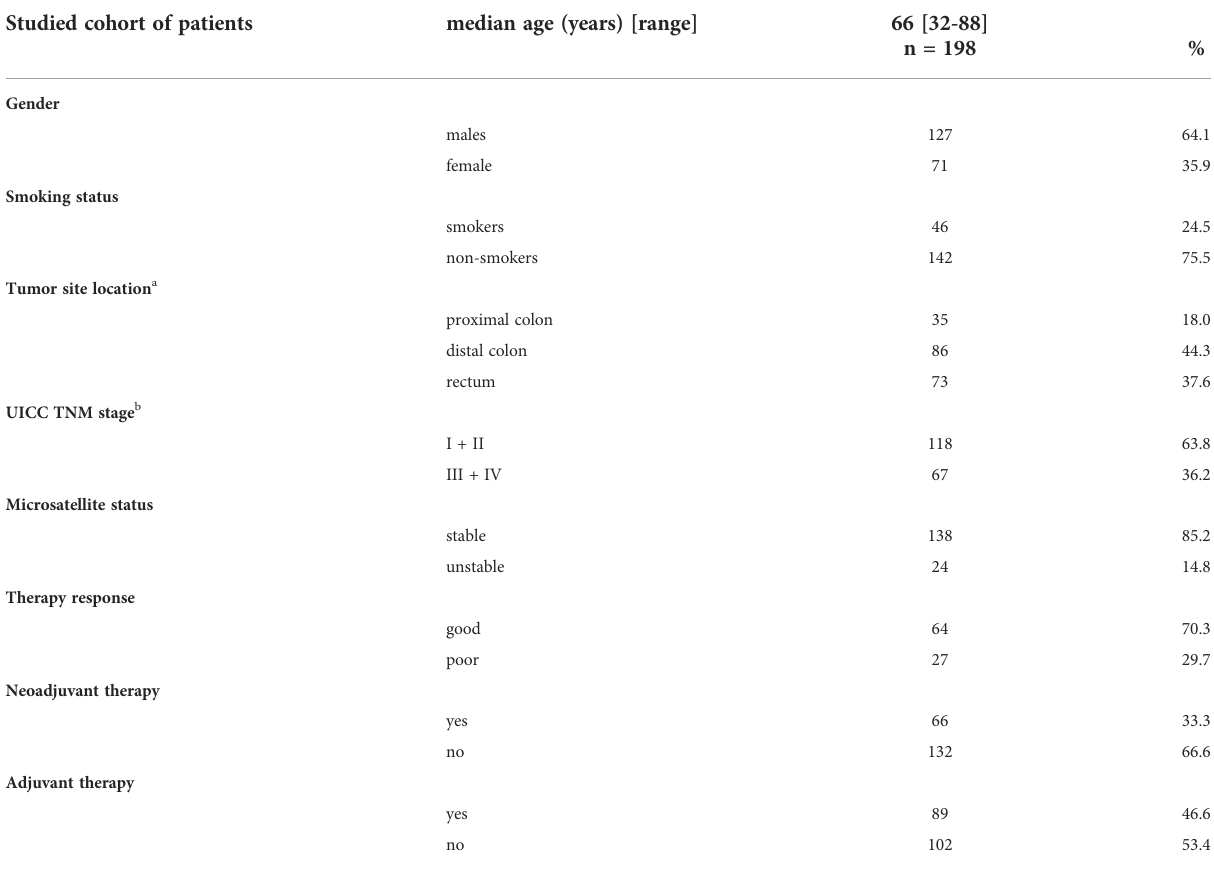
TABLE 1 Patients ’